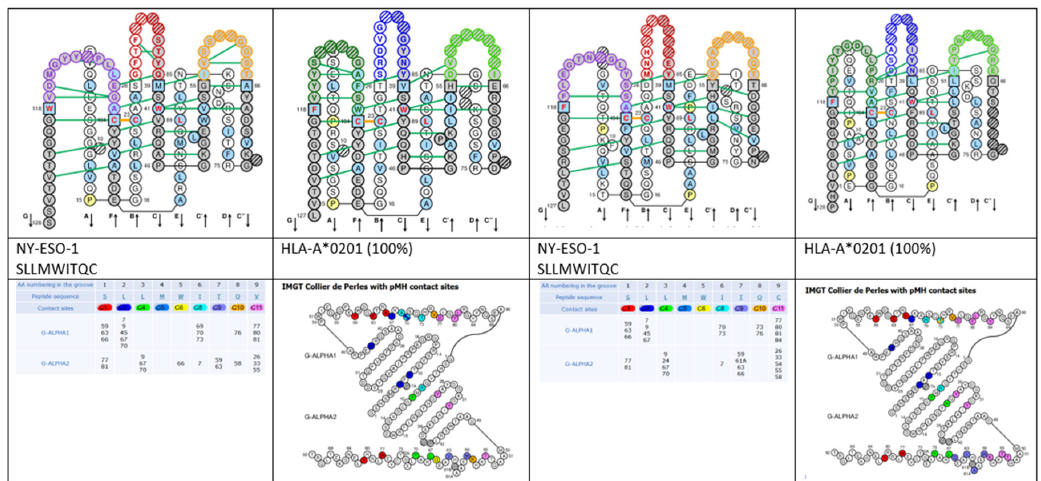
Figure 34. Contact analysis and IMGT Collier de Perles of a TR-mimic antibody and of a TR targeting peptide-HLA. VH and V-LAMBDA of the IG Fab 3M4E5 and V-BETA and V-ALPHA of the TR 1G4_a58b61 target the NY-ESO-1 peptide presented by HLA-A*02:01 [311,312]. From top to bottom are shown: 1. contacts with the ligand, 2. contacts with G-ALPHA1, 3. contacts with G-ALPHA2, 4. IMGT Collier de Perles on one layer, 5. IMGT Collier de Perles on two layers with hydrogen bonds, 6. contacts of the NY-ESO-1 peptide SLLMWITQC with the MH1 HLA-A*02:01 groove [313–315]. The CDR1-IMGT, CDR2-IMGT and CDR3-IMGT are represented in red, orange and purple for the IG VH and the TR V-BETA, and in blue, green, bluegreen for the IG VL, here V-LAMBDA and for the TR V-ALPHA. Three-dimensional structure PDB codes are 3gjf, for Fab 3M4E5 (IG / pMH1), and 2p5e, for 1G4_a58b61 (TR / pMH1) (IMGT ® http: // www.imgt.org, IMGT / 3Dstructure-DB).